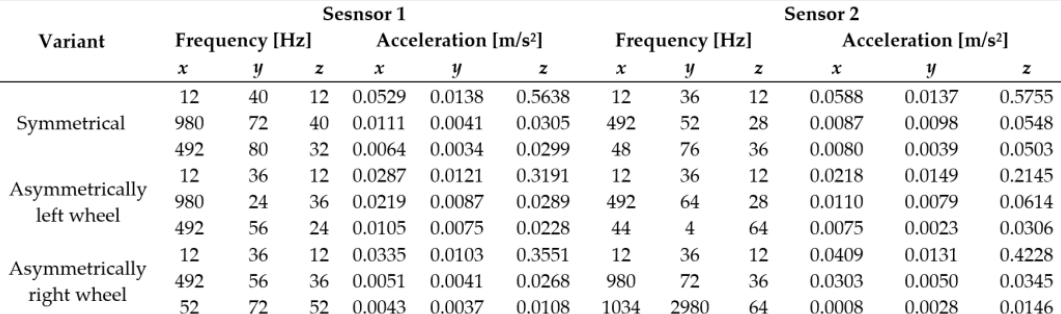
Figure 15. Symmetrical arrangement of the obstacles — photo.